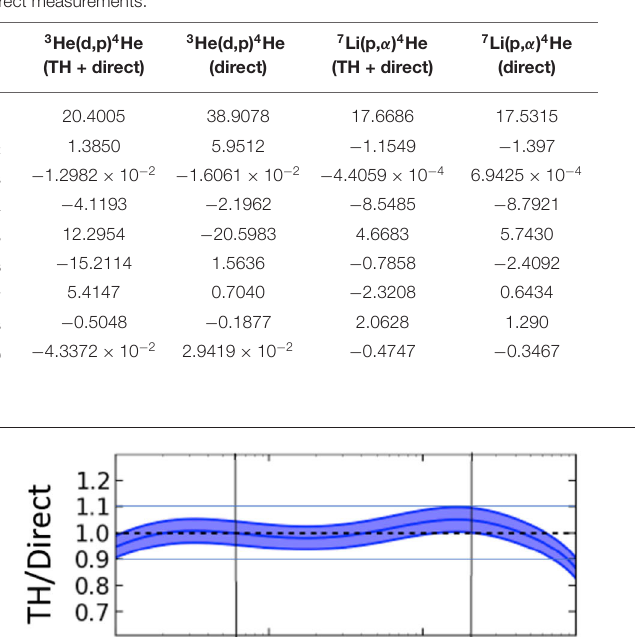
Frontiers in Astronomy and Space Sciences |